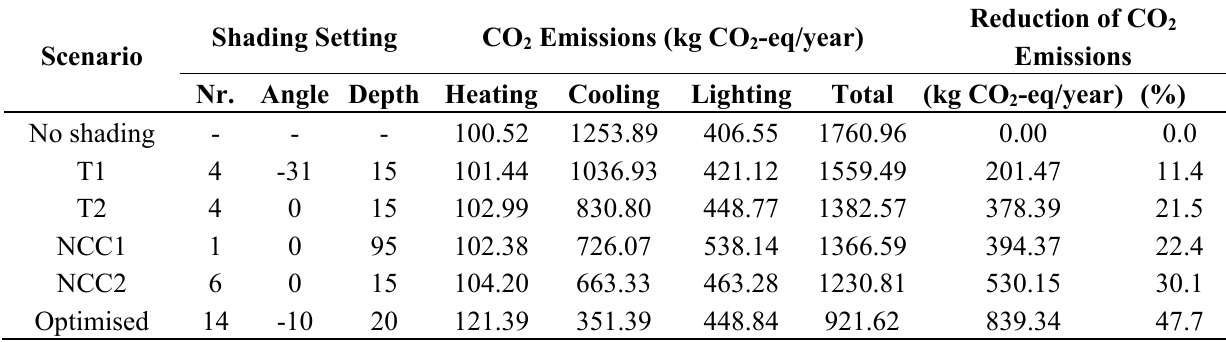
Table 4. Results summary and comparison for all simulation scenarios. CO 2